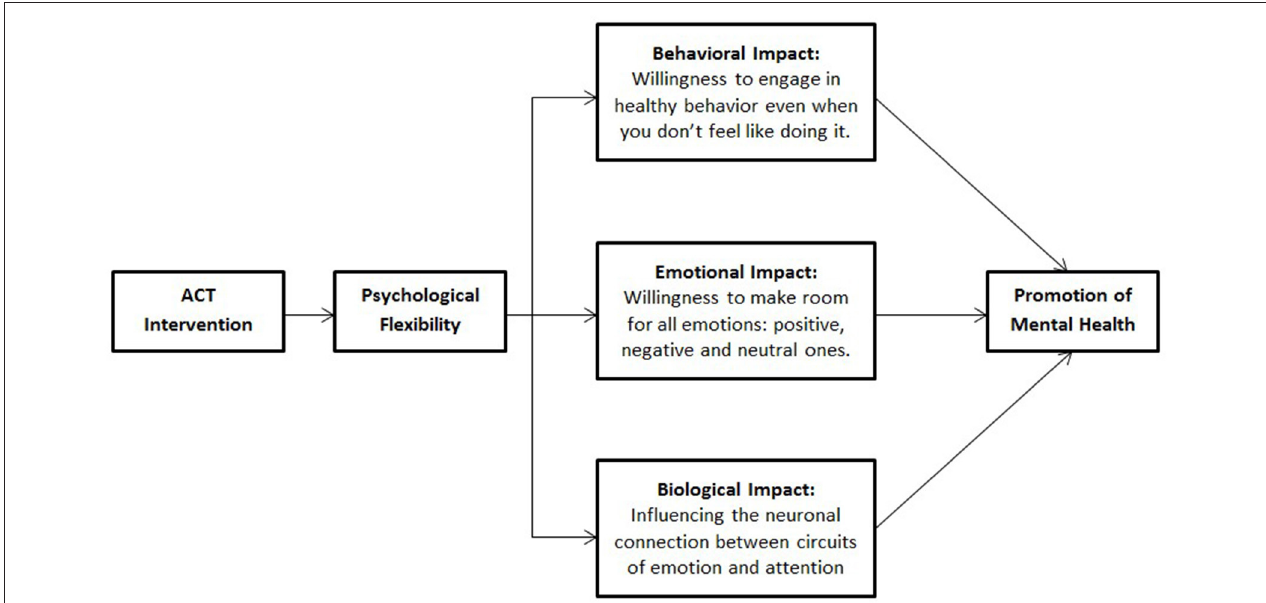
FIGURE 1 | Proposed conceptual